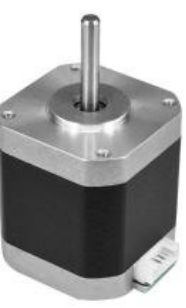
Figure 19. Ball-type linear slide.